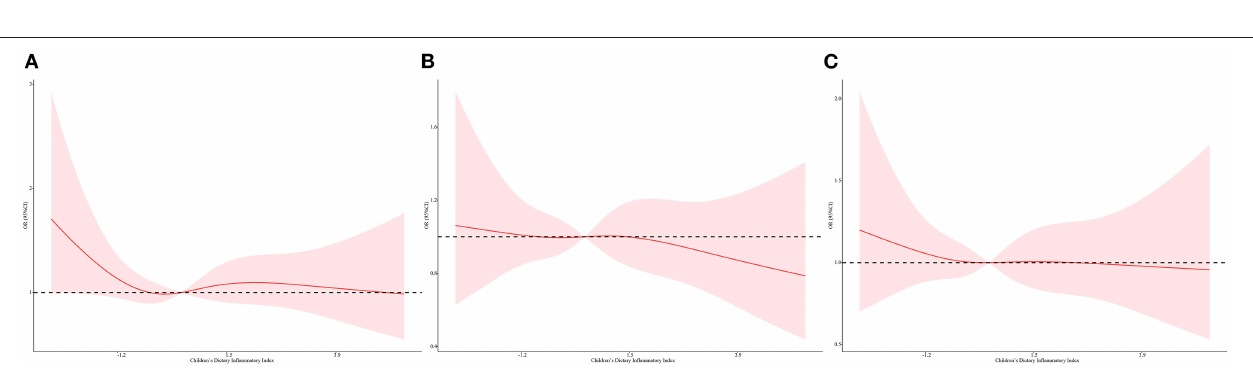
FIGURE 2 | Restricted cubic spline regressions of C-DII and the inflammatory markers after adjusting for different covariates in model 3 for (A) lymphocyte count, (B) neutrophil count, (C) ferritin (D) CRP, (E) alkaline phosphatase. The red line and area represent the estimated OR values and their corresponding 95% CI. Model 3 adjusted for age, sex, race/ethnicity, cotinine exposure status, BMI, poverty-income ratio, body fat percentage and energy intake.